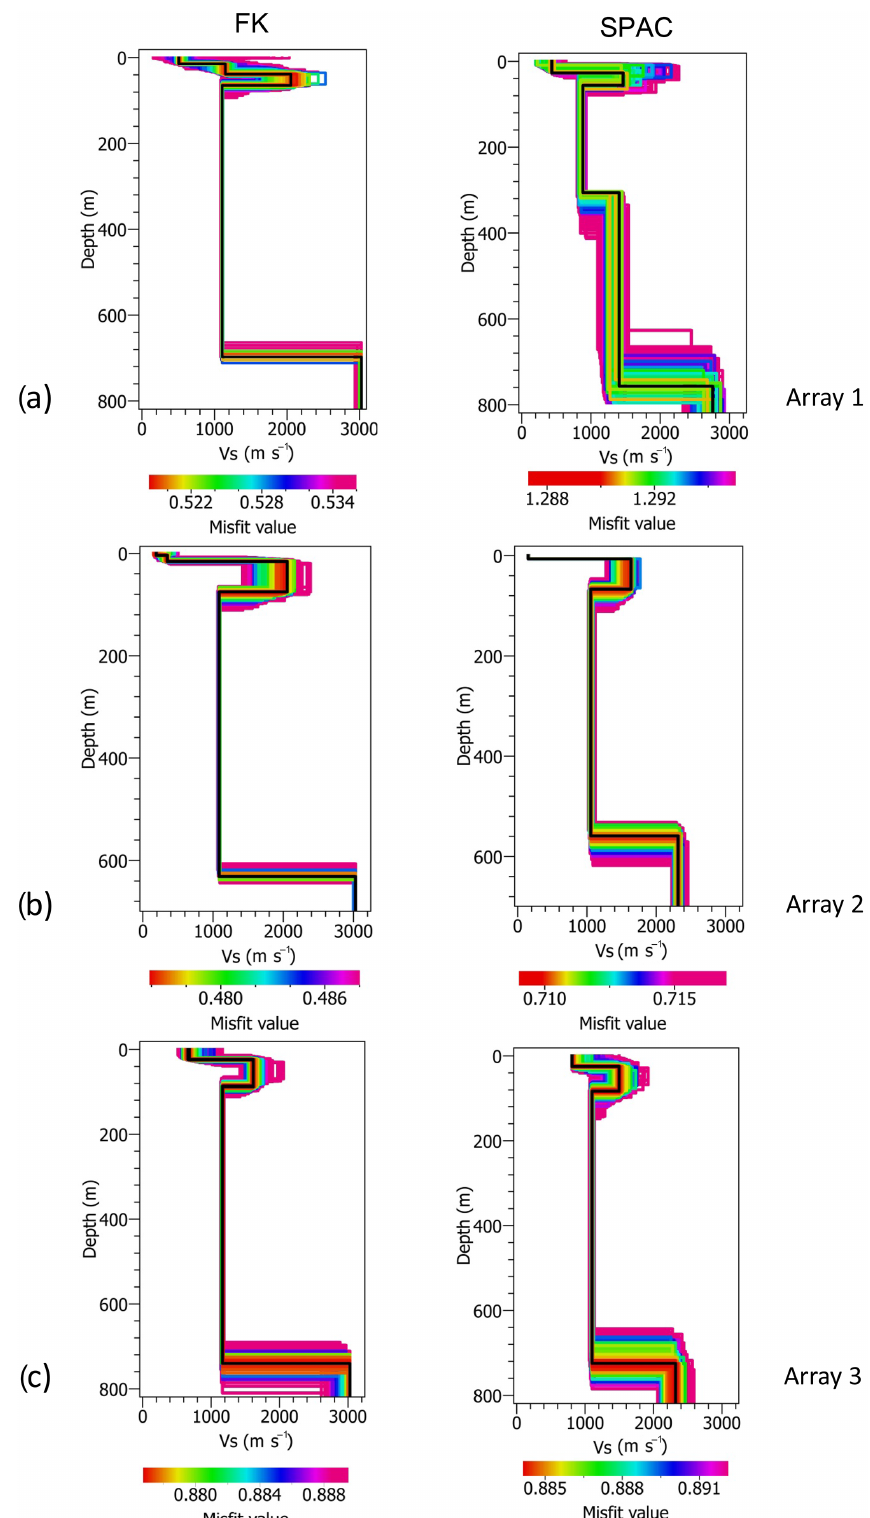
Figure 8. Shear-wave velocity models obtained from the dispersion curve inversion (FK method, left) and the autocorrelation curves inversion (SPAC method, right) array technique for (a) array 1, (b) array 2 and (c) array 3. The models have a misfit lower than 0.9. Colour code shows the misfit of each model. The black line represents the shear-wave velocity model with minimum misfit. Solid Earth, 7, 685–701, 2016